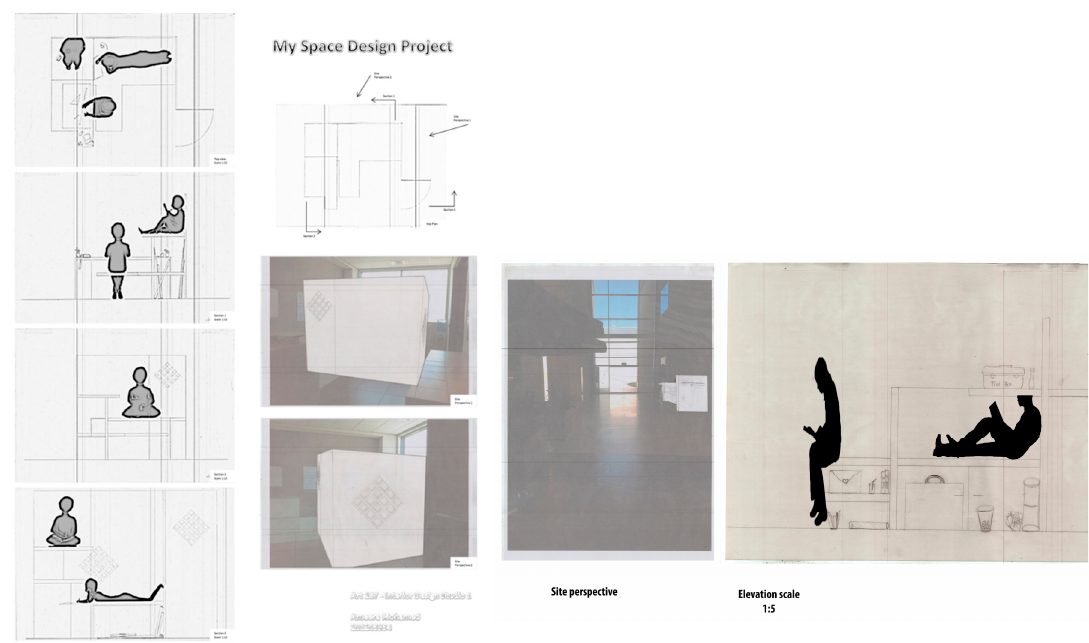
Figure 15. Two A1 posters showcasing the proposed prototype for My Space illustrated through a site plan, a series of orthographic drawings and site collaged perspective. Work sample from Project Part III. Courtesy of Ameera Al Marzooqi and Fatima Ismail.